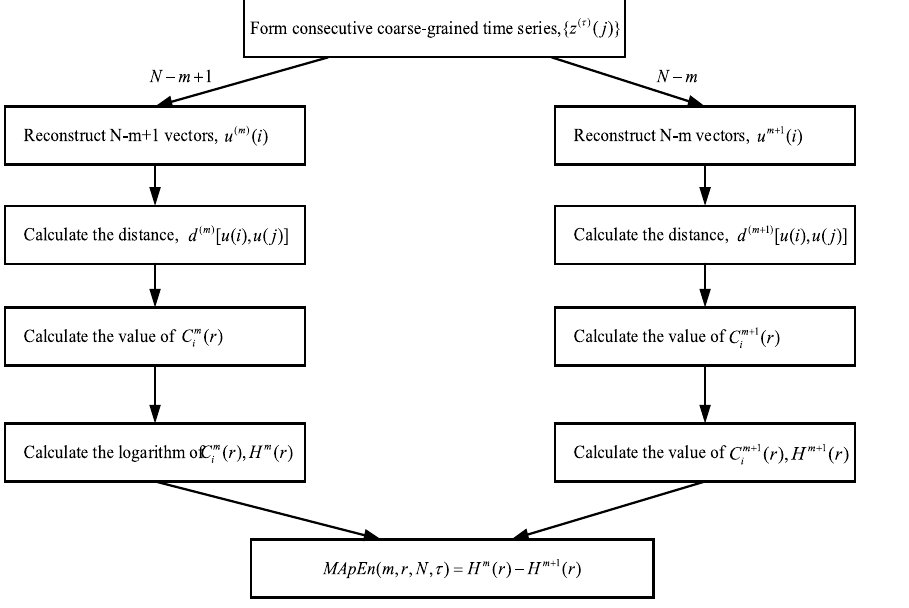
Figure 5. Flowchart of multiscale approximate entropy algorithm.